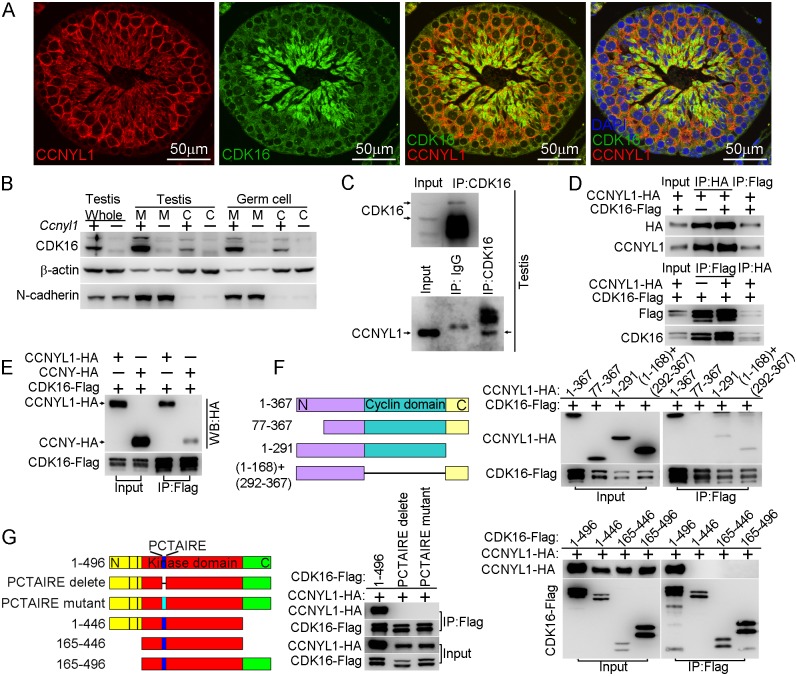
Interaction of CCNYL1 with CDK16.(A) Co-immunolabeling of CCNYL1 (red) and CDK16 (green) in testicular sections of WT mice. Nuclei were labeled with DAPI (blue). Scale bar: 50 μm. (B) CDK16 protein expression was measured in membrane extracts and cytoplasmic extracts isolated from testes or germ cells of WT and Ccnyl1-/- mice. N-cadherin served as the membrane protein control, while β-actin served as the cytoplasmic protein control. (C) CDK16 protein was immunoprecipitated from testicular lysate with CDK16 antibody. Both CDK16 and the Co-immunoprecipitated CCNYL1 were analyzed by western blotting. (D) HEK293T cells were co-transfected with N-terminal tagged CCNYL1-HA and C-terminal tagged CDK16-Flag plasmids. CCNYL1-HA and CCNYL1-Flag proteins were co-immunoprecipitated using either anti-HA or anti-Flag conjugated agarose before analyzed by western blot. (E) HEK293T cells were co-transfected with CDK16-Flag and CCNYL1-HA, or CDK16-Flag and CCNYL-HA plasmids, proteins were co-immunoprecipitated by using anti-Flag conjugated agarose before analyzed by western blotting. (F) Truncated CCNYL1-HA variants were coexpressed with CDK16-Flag in HEK293T cells. The interactions were analyzed by CoIP experiments followed by western blotting. (G) CDK16-Flag variants were co-expressed with CCNYL1-HA in HEK293T cells. The interactions were analyzed by CoIP experiments followed by western blotting. PCTAIRE is the conserved sequence of CDK16 protein. PCTAIRE mutant (PCTAIRE was mutated to ACAAIAA).